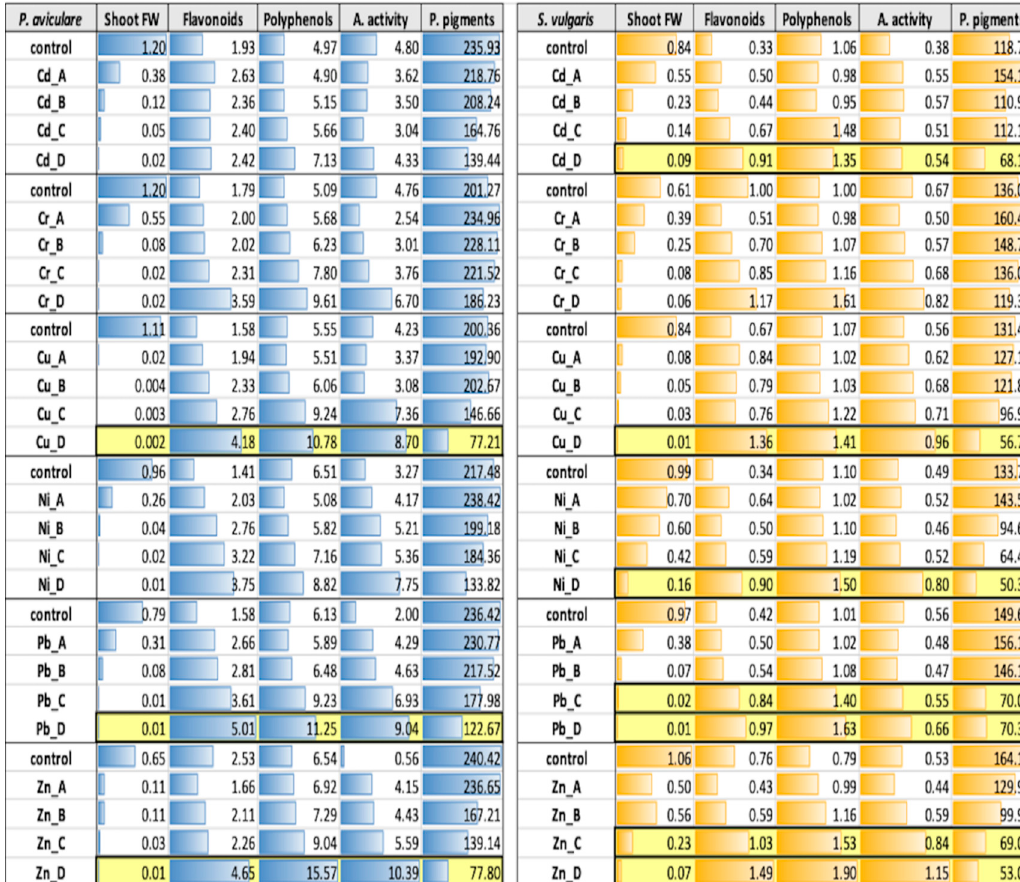
Table 2. Fresh weight (gFW), antioxidant activity (mg ascorbic acid eq / gFW), flavonoid (mg catechin eq / gFW), polyphenol (mg gallic acid eq / gFW) and photosynthetic pigment contents ( µ g / gFW) in P. aviculare and S. vulgaris shoots. Each value is the average of the five populations, tested in three biological replicates ( n = 15). A 15% SE error applies to all data. Yellow bars indicate concentrations giving acute toxic e ff ects. Blue and orange bars highlight the specific data variability with respect to the highest value of each column variable. A. activity: antioxidant activity, P. pigments: